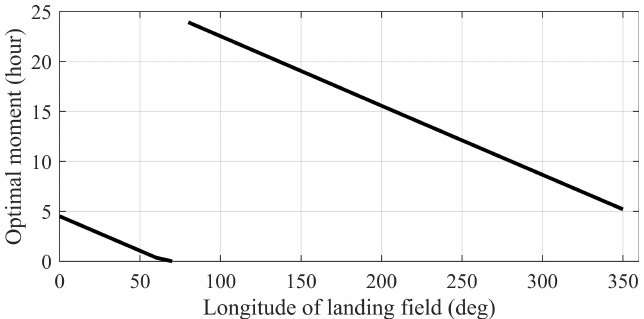
Figure 8. Relationship between longitude of landing field and optimal re-entry moment in a day.